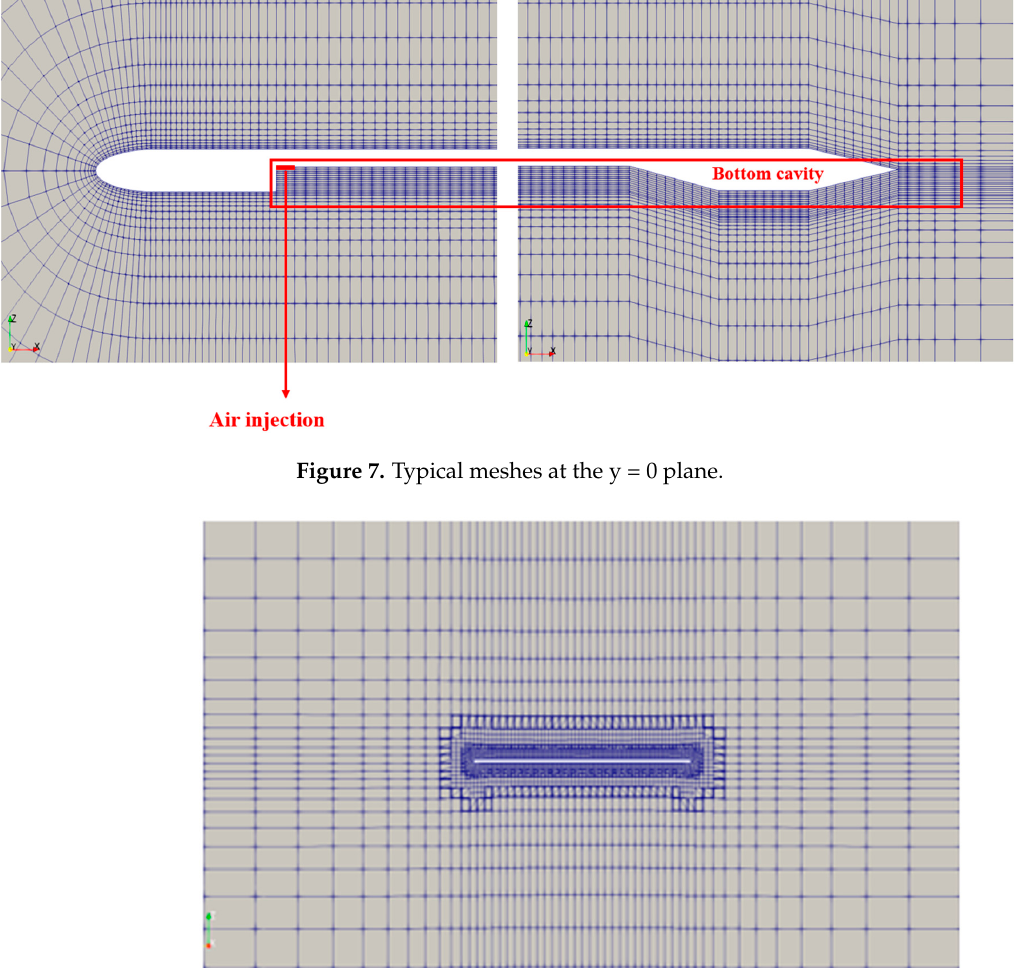
Figure 7. Typical meshes at the y = 0 plane.